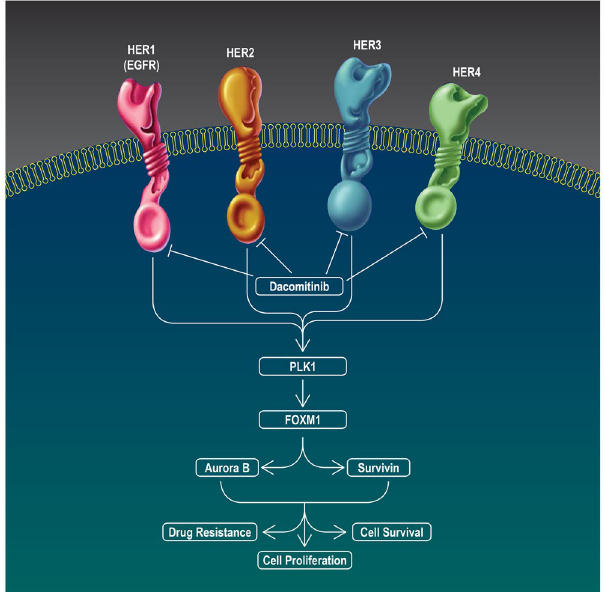
Figure 6. Schematic illustration of the anti-tumour effects of dacomitinib on the EOC cells. Dacomitinib inhibited cell growth, induced apoptosis and restored cisplatin sensitivity through blockade of the PLK1/ FOXM1 axis and its downstream targets Aurora B and